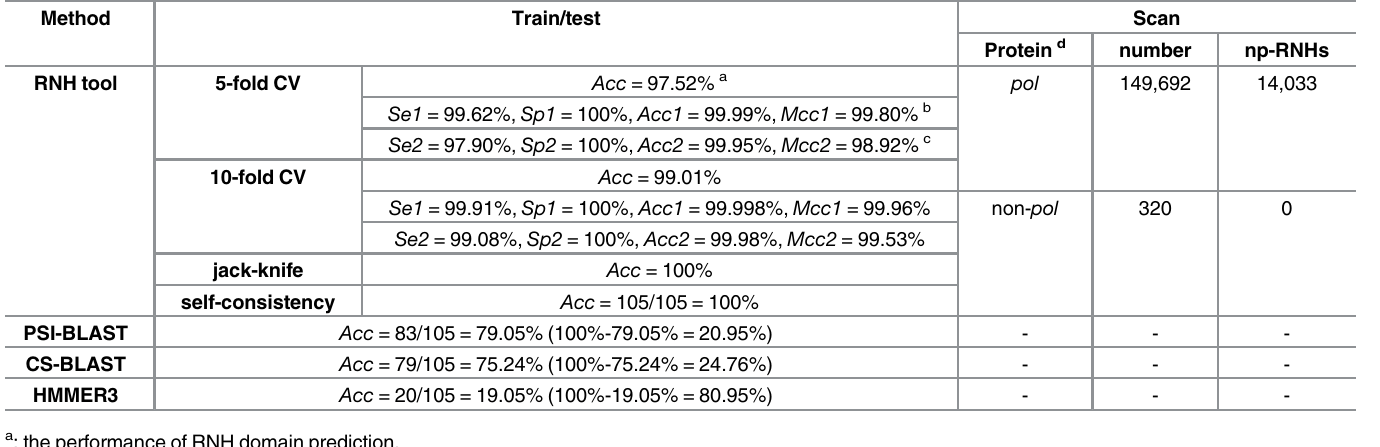
Table 1. Comparison results between RNH tool and three other classical database search tools.